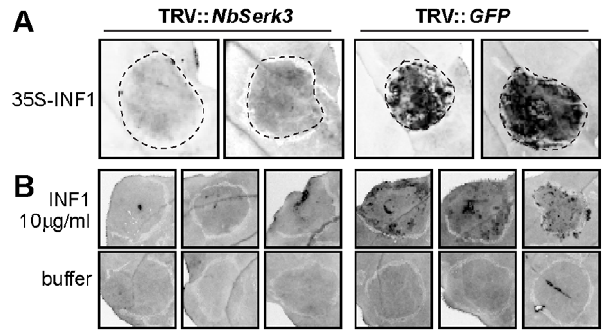
Figure 6. Cell death triggered by INF1 in N. benthamiana requires NbSERK3 variants. Leaves of NbSerk3 or control silenced plants were infiltrated with A. tumefaciens harbouring 35S-INF1 for transient in planta expression (A) or with P. infestans purified INF1 (B). Phenotypes were scored 6 dpi by visualizing cell death (dark areas) using UV trans-illumination.